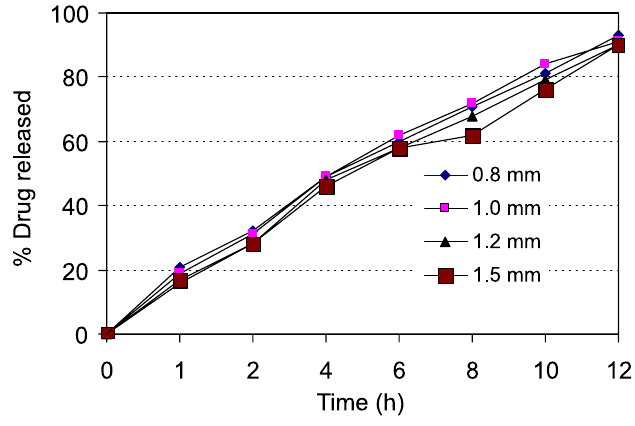
FIGURE 7 - Effect of extruder screen aperture size, ( -♦- ) 0.8mm, ( -■-) 1.0 mm, (-▲-) 1.2mm and (-■- ) 1.5mm, on in vitro sertraline